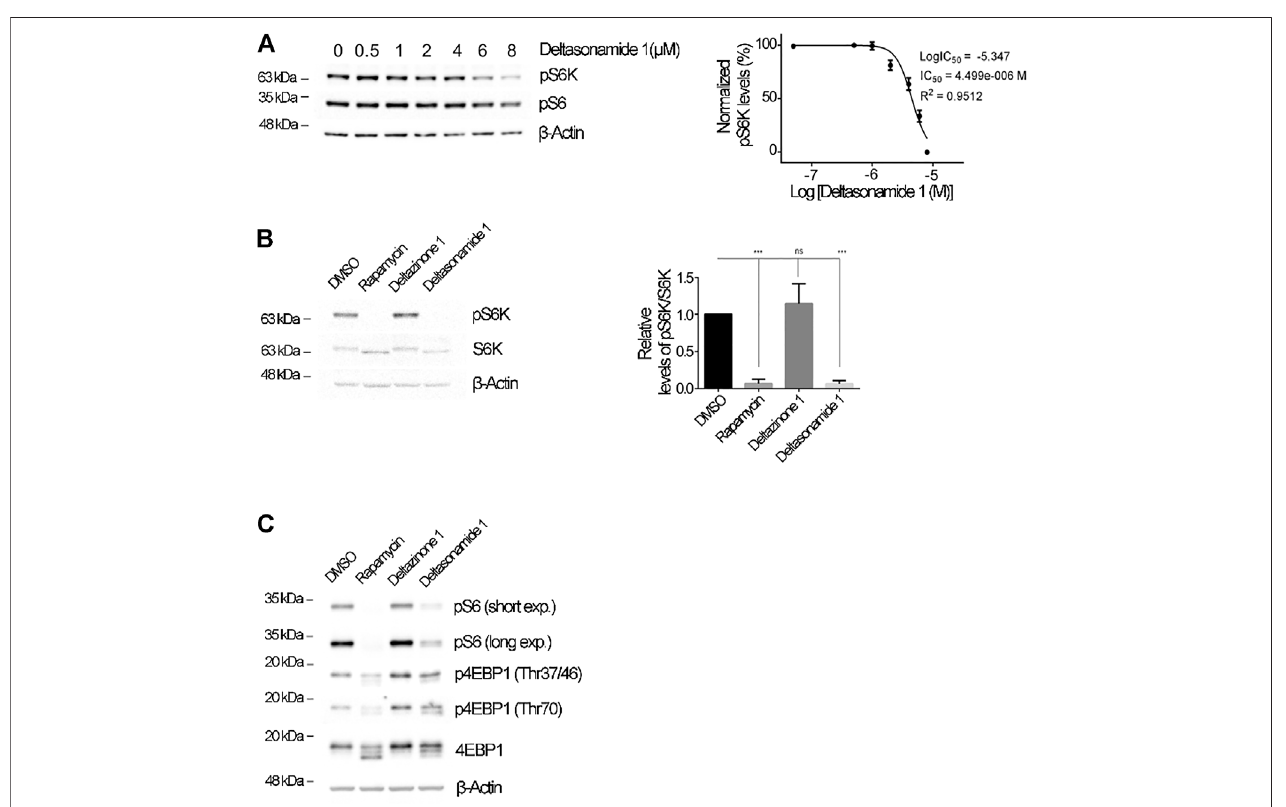
FIGURE 3 | Deltasonamide 1 inhibits the mTORC1 signaling pathway in Tsc2-null MEFs (A) . Tsc2-null MEFs treated with DMSO, rapamycin (20 nM), Deltazinone 1 (6 µM),orDeltasonamide1(6 µM)for24h.Left,lysateswerecharacterizedbyimmunoblottingoftheindicatedproteins.Right,densitometricanalysisofphospho-S6Klevels normalized to S6K total levels. β -actin, loading control (B) . Tsc2-null MEFs treated with DMSO or Deltasonamide 1 (0.5 – 8 µM) for 24 h. Left, lysates were characterized by immunoblotting of the indicated proteins. Right, the dose-response curve for Tsc2-null MEFs treated with Deltasonamide 1 for 24 h. Normalized pS6K levels at each drug concentration is shown as a percentage of the normalized pS6K levels with DMSO. IC 50 , half-maximal inhibitory concentration (C) . Tsc2-null MEFs treated as in (A) . Lysates were characterized by immunoblotting of the indicated proteins. Phospho-4EBP1 (Thr37/46), phospho-4EBP1 (Thr70), 4EBP1 total and β -actin (loading control). Results are representative of at least three independent experiments. Data are expressed as the mean ± SD ( p < 0.05).